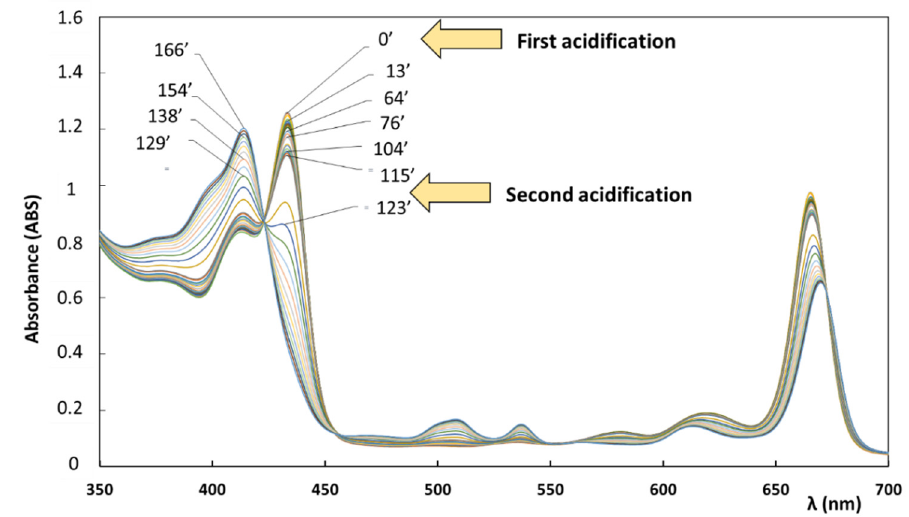
Figure 4. Evolution of the UV-vis absorption spectrum of a test sample (‘CA_20.5 ′ ) containing chlo- rophyll a diluted in refined oil, after a first (at time = 0 ′ ) and a second (at time = 117 ′ ) acidification, as described in the text. Spectra were recorded during time, from 0 to 166 min, following the complete conversion from chlorophyll a to pheophytin a. The optical path was 0.5 cm.